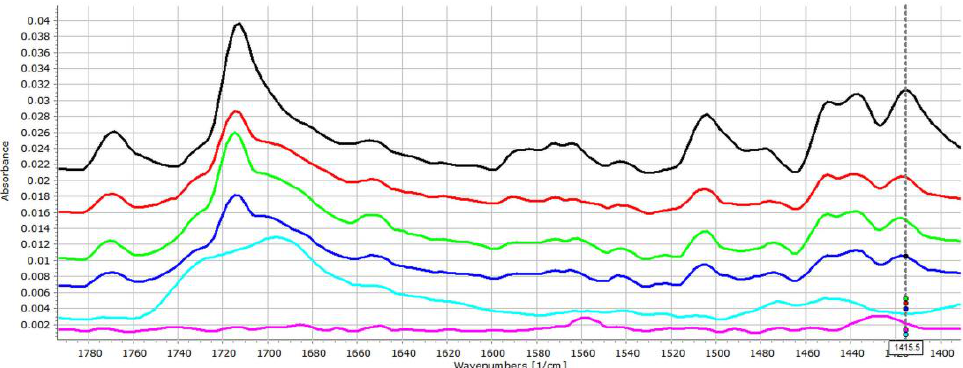
Figure 3. FT-IR spectra (1400 – 1800 cm −1 range) of the ACE ( black ), ACE-PVC:EL 75:25 ( red ), ACE- PVC:EL 50:50 ( green ), ACE-PVC:EL 25:75 ( deep blue ), EL ( light blue ) and PVC ( purple ) samples; multicursor indicates the place of peak shift in the spectrum.